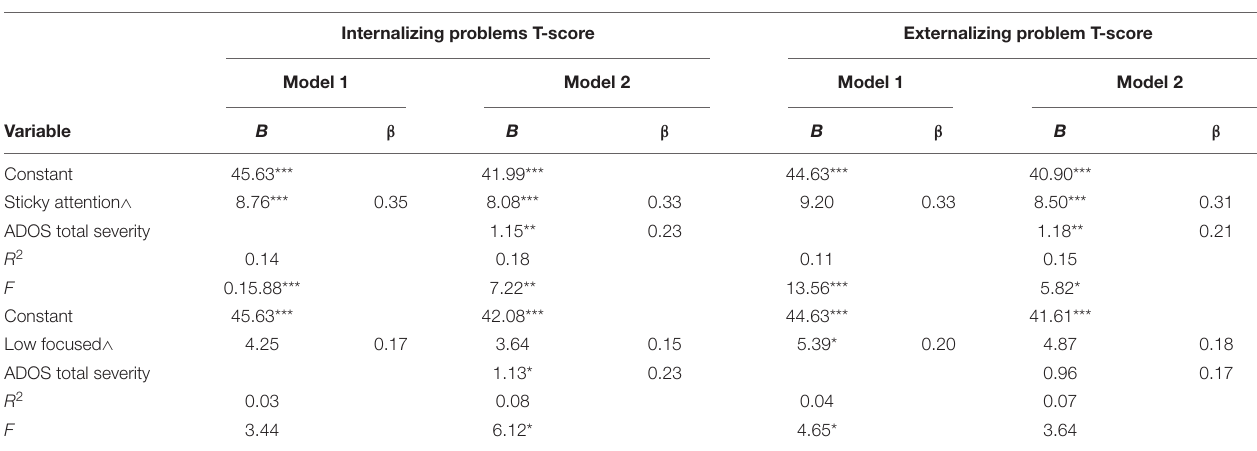
TABLE 6 | Predictive relationships between 5-year internalizing and externalizing problems and temperament